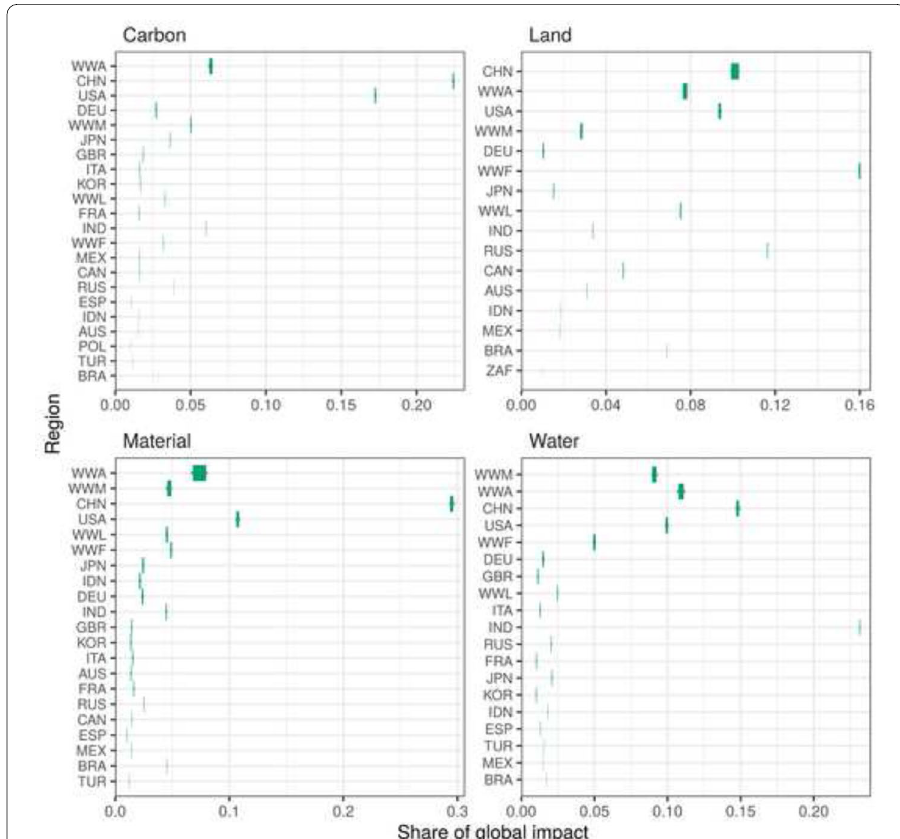
Fig. 4 The absolute variability of the national footprints expressed as variability in the contribution to the global total impacts. The bars cover the range between the 2.5th and 97.5th percentiles. The grey whiskers extend to the min/max of the sample. The regions are ordered by their SD from top (high) to bottom (low). All regions with a share of less than 1% of the global impact are not included in the